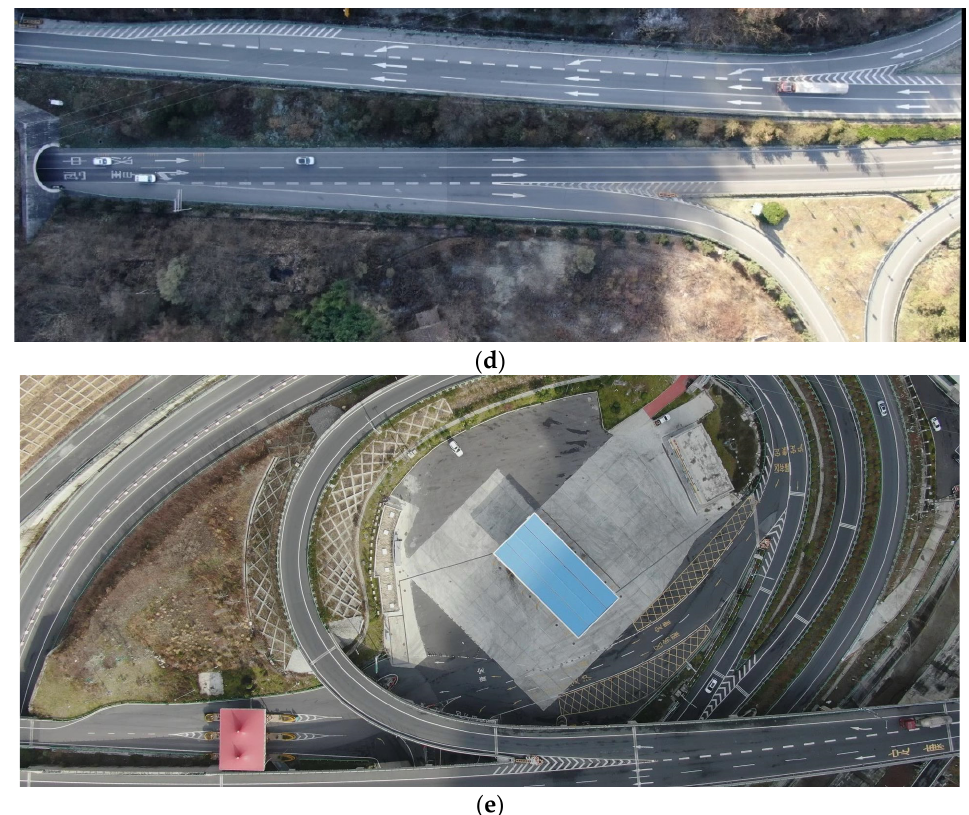
Figure 1. Research locations: ( a ) main section of Baomao expressway; ( b ) Tianquan interchange exit of Yakang expressway; ( c ) Duogong interchange ring ramp of Yakang expressway; ( d ) small net distance section of Huangguan tunnel of Beijing–Kunming expressway; ( e ) Luding interchange ring ramp of Yakang expressway.